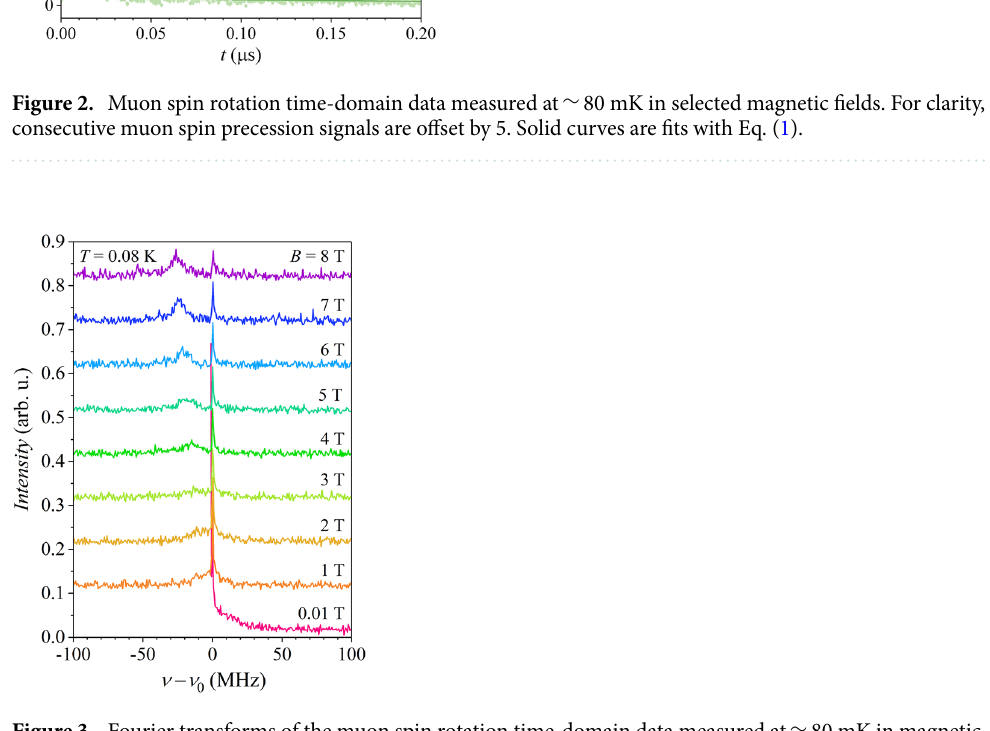
80 mK in magnetic ∼